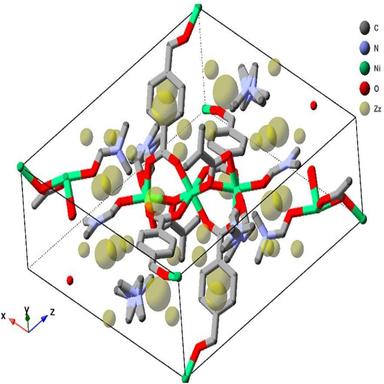
Cavities in the structure per unit cell. The cavities are represented by grey-yellow spheres (Zz).